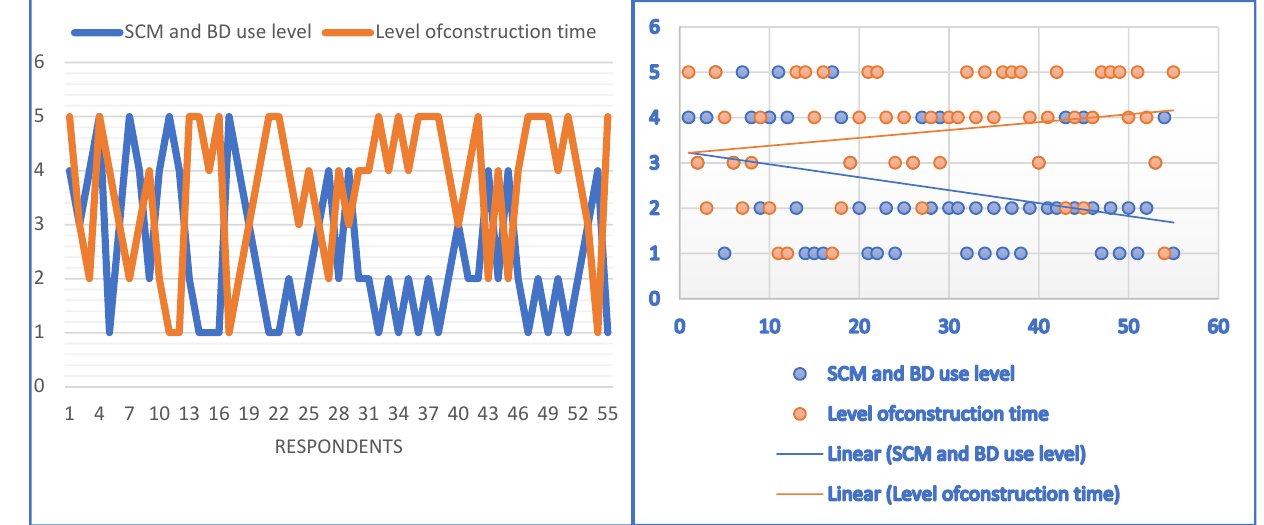
Figure 4. Relationship between SCM and BD use level and level of construction time.